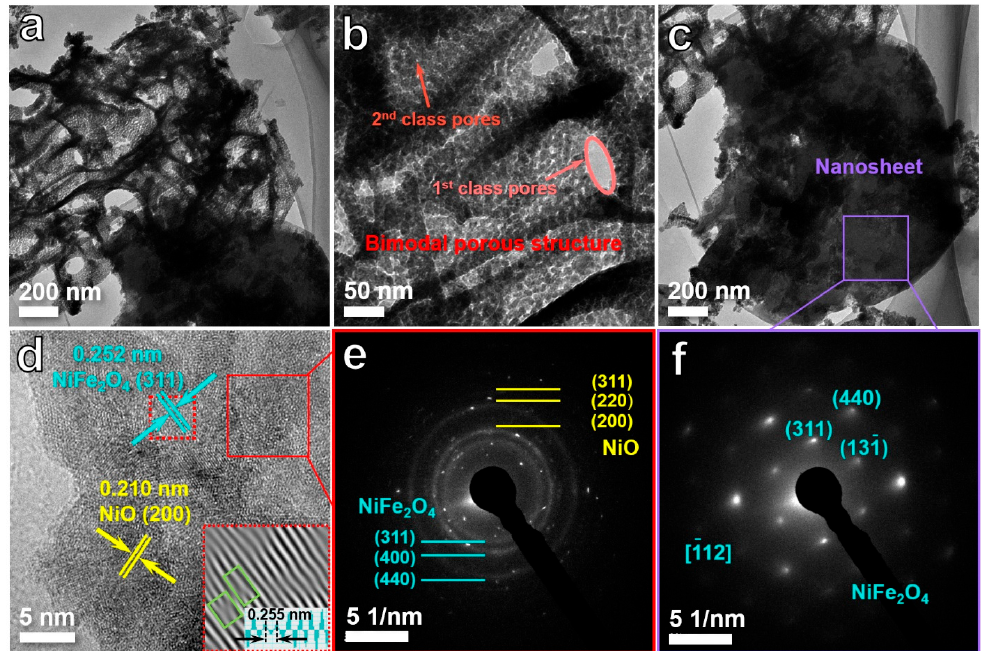
Figure 2. ( a – c ) TEM images of the D5 sample at different magnifications. ( d ) HRTEM image of porous ligament networks in the D5 sample, IFFT pattern and lattice spacing profiles of selected area (inset). The SAED patterns of porous ligament network ( e ) and nanosheet ( f ) in the D5 sample. XRD tests were performed to analyze the phase composition of the products. As dis- played in Figure 3a, the patterns included three strong diffraction peaks for each sample. According to JCPDS cards (NO. 54-0964, NiFe 2 O 4 ; NO. 65-5745, NiO), the three diffraction